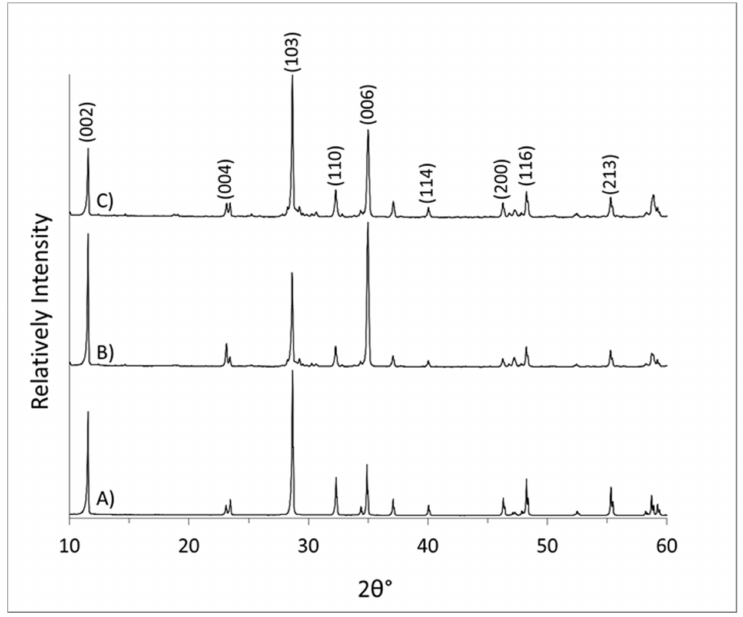
Figure 1. XRD pattern of BICUVOX platelets synthesized by molten salt synthesis